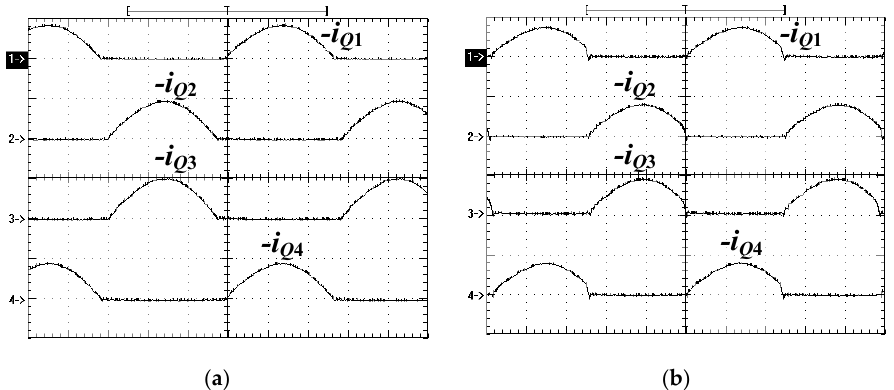
Figure 9. Measured switch currents of Q 1 –Q 4 under full load (a) V H = 750 V (b) V H =800 V (- i Q 1 ~- i Q 4 : 50 A/div; time: 2 μ s).